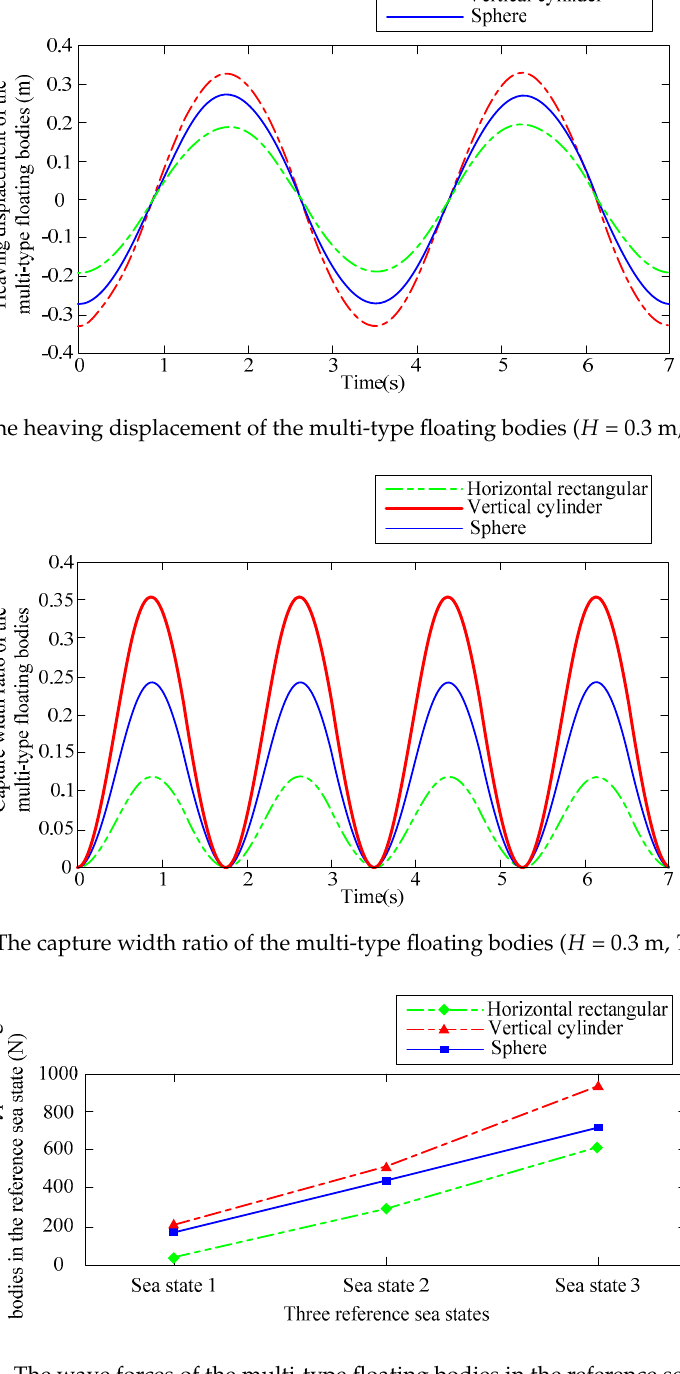
Figure 8. The wave forces of the multi-type floating bodies in the reference sea state.